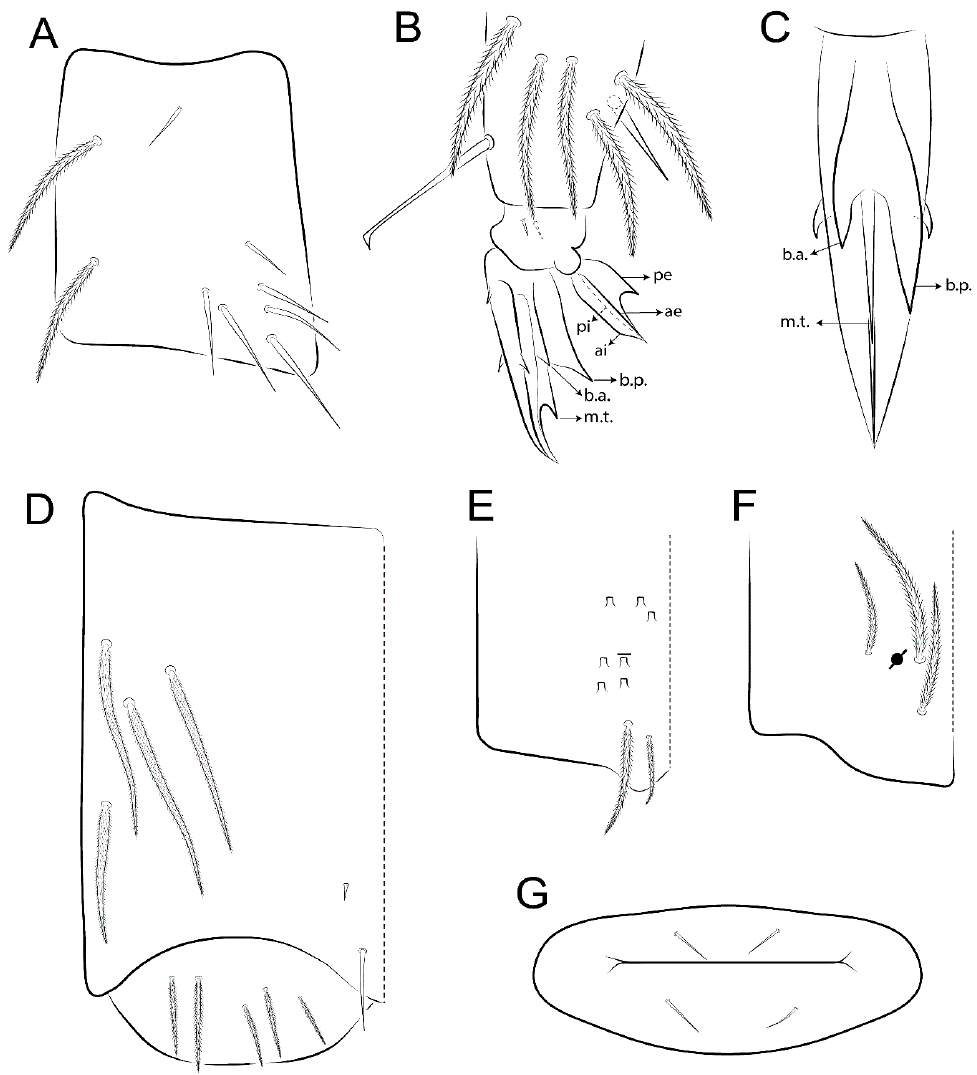
Figure 33. Pseudosinella taurina sp. nov.: trunk appendages. ( A ) trochanteral organ; ( B ) distal tibiotarsus and empodial complex III (anterior view); ( C ) unguis (inner view); ( D ) collophore (lateral view); ( E ) distal part of manubrium (ventral view); ( F ) manubrial plate (dorsal view); ( G ) female genital plate (ventral view).